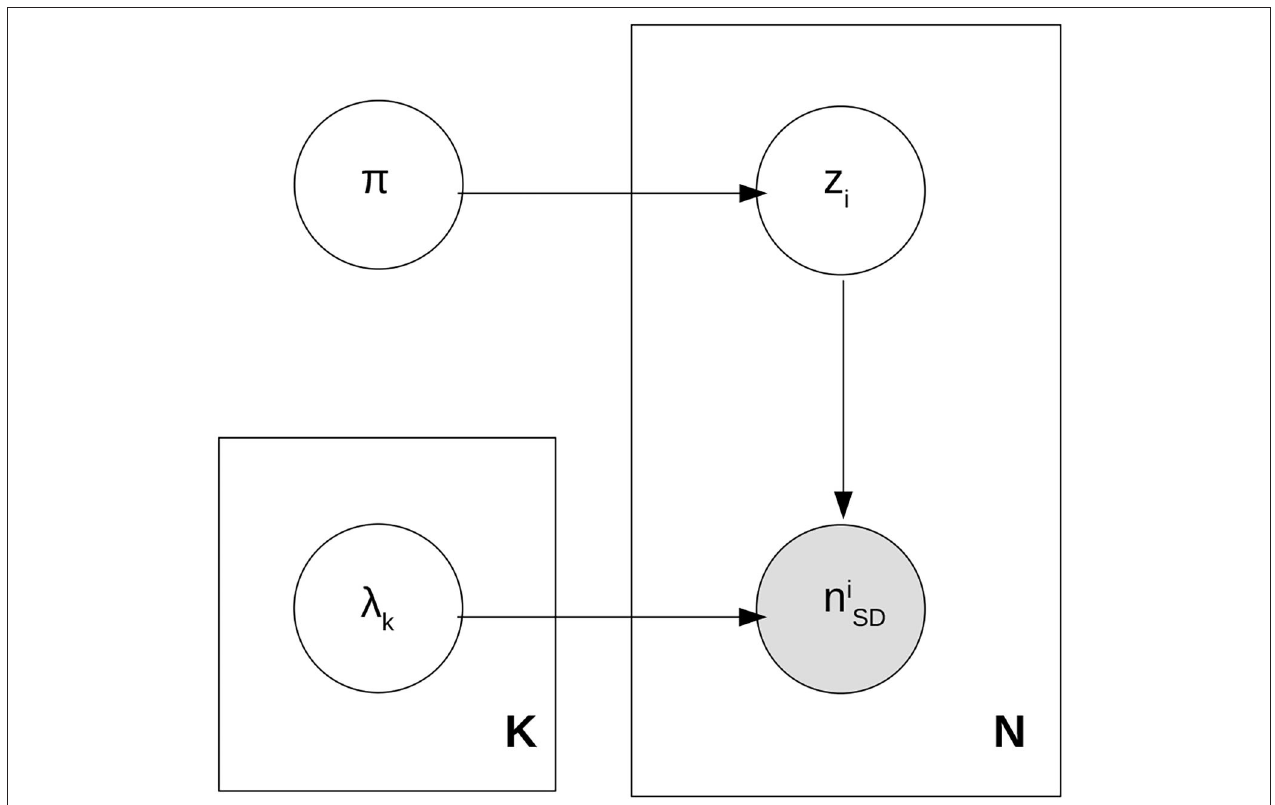
FIGURE 1 | Generative process for n SD due to a mixture of quark and gluon